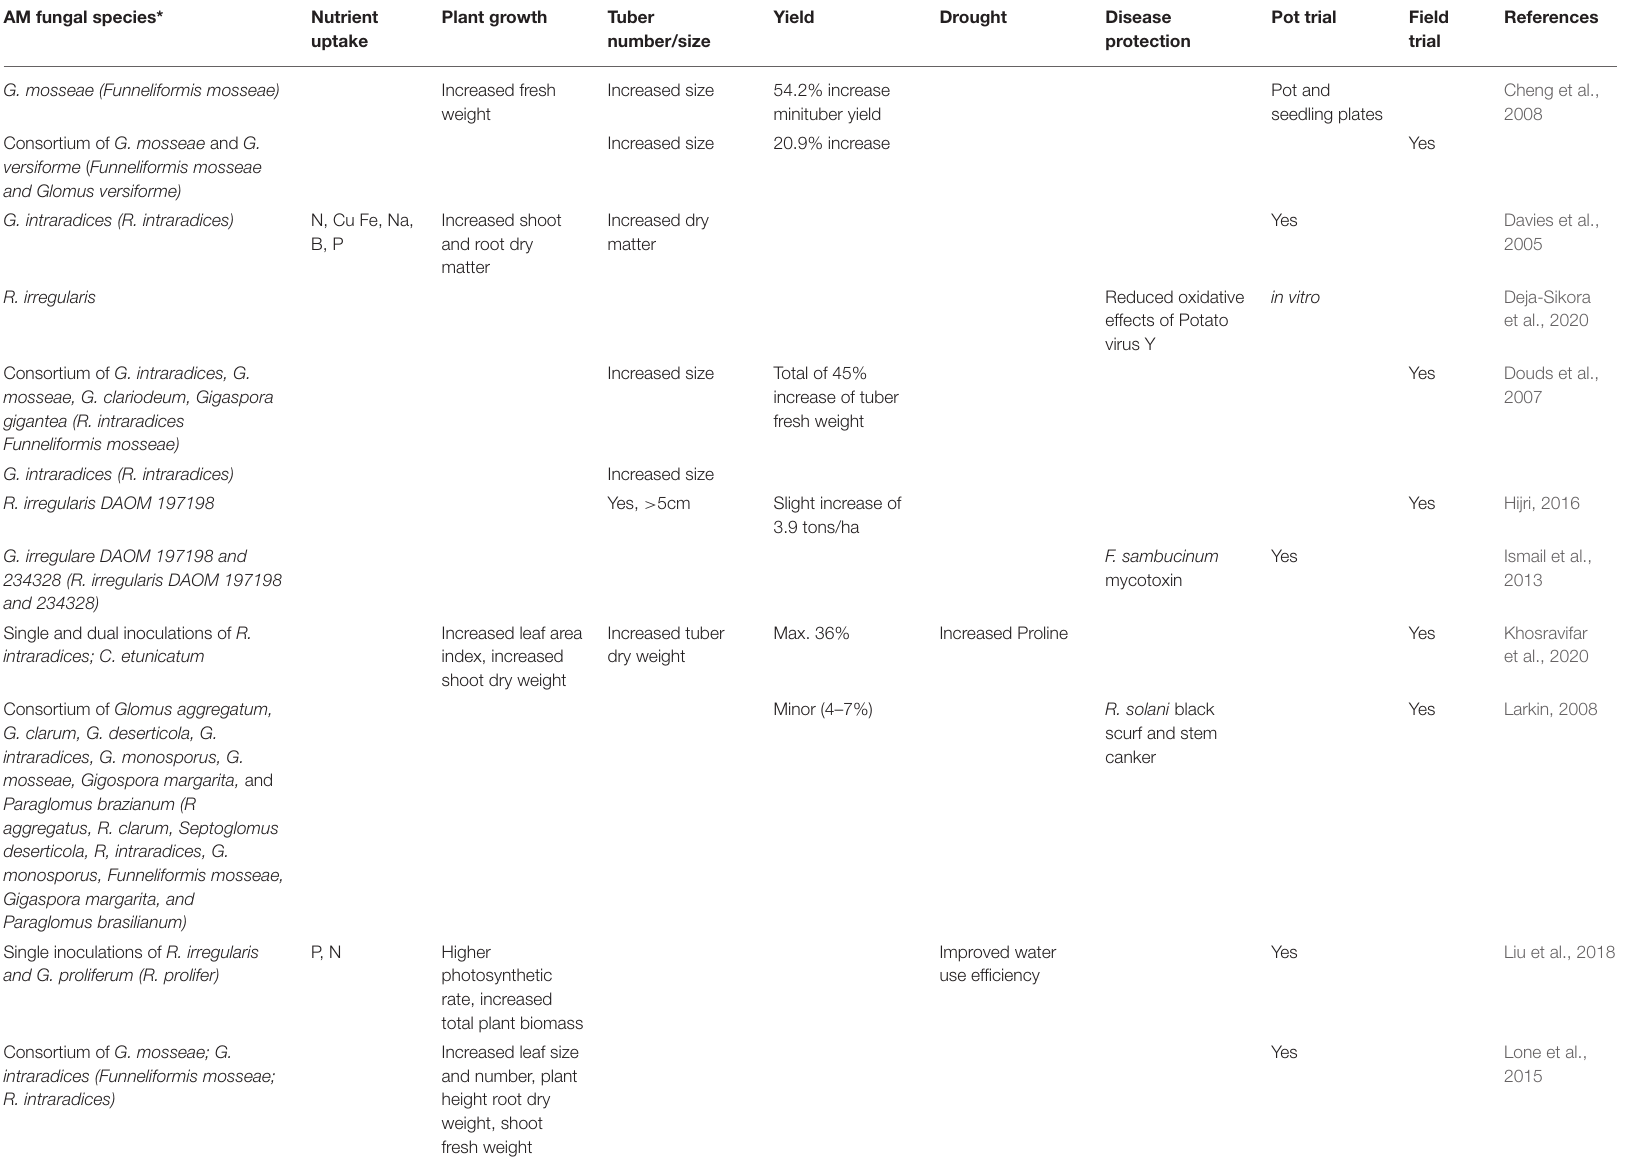
TABLE 1 | Summary of AM fungal species and the benefits they confer to the potato